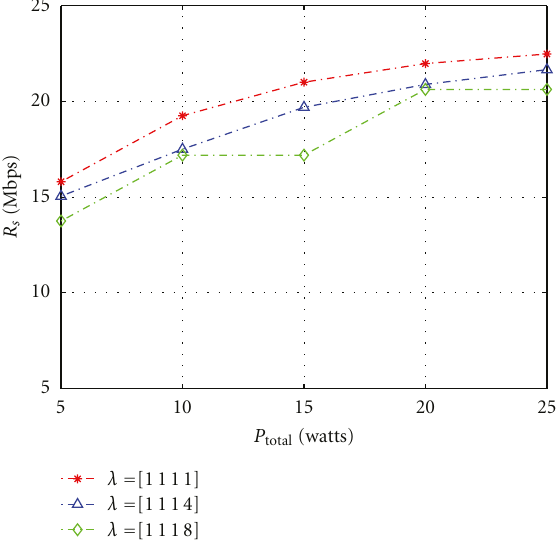
Figure 2: Average total CRU bit rate, R s , versus total CRU transmit power, P total , with I total = 0 . 02 W, P m = 5W, and λ = [1 1 1 4].